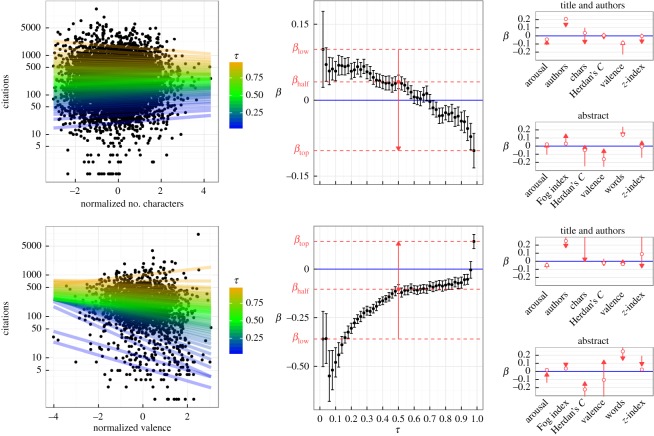
Relation between different factors and the number of citations in two journals: Science (top) and Nature Genetics (bottom). Left-side plots: each black dot corresponds to one paper, and lines show quantile regression (QR) results for colour-coded quantiles τ={0.02,0.04,…,0.98}. Middle panels: β coefficients (slopes of QR in the left panel) as a function of quantile τ. The red arrows (summary pointers) show βlow≡β(τ=0.02), βhalf≡β(τ=0.5) and βtop≡β(τ=0.98), as, respectively, the nock, a circle on the shaft, and the head of the arrow. Right panels: summary pointers for all factors.